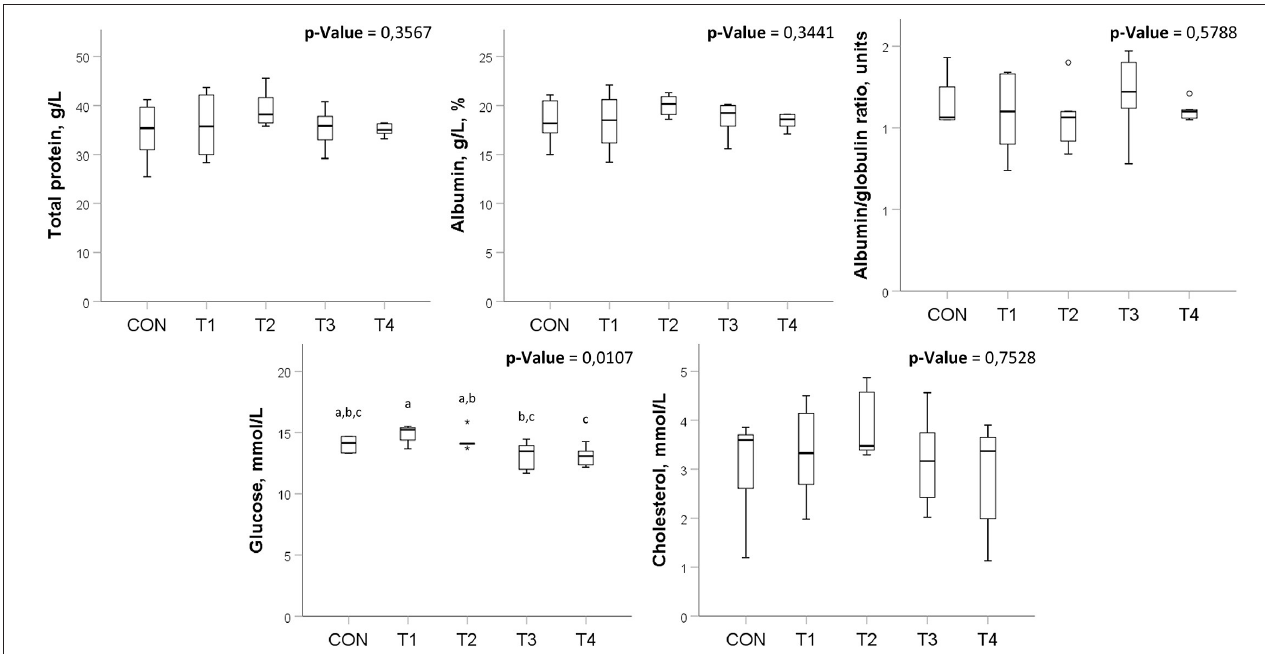
FIGURE 3 | Biochemical blood analysis in broilers treated with probiotics. Means within the same row without common superscripts are significantly different ( p < 0.05). CON, control group; T1, group treated with B. subtilis KATMIRA1933; T2, group treated with B. subtilis KB16; T3, group treated with B. subtilis KB41; T4, group treated with B. amyloliquefaciens KB54. The data was obtained from two birds per replicated with 8 birds per group in